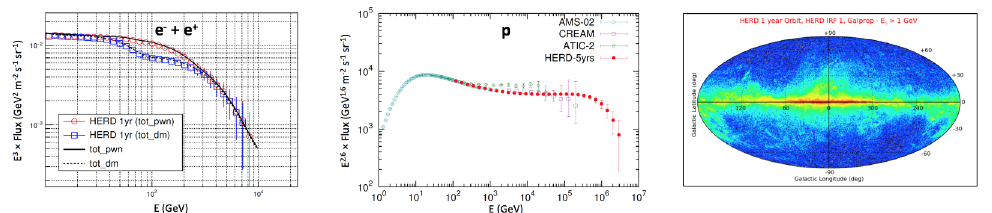
Figure 1. Expected e − + e + flux as measured by HERD with one year data accumulation. HERD will clearly distinguish between a smooth spectrum, due to a PWN, or a spectrum with a “kink”, due to DM (left). Expected proton flux as measured by HERD with five years data accumulation. HERD can reach the PeV region with unprecedented statistics (center). Expected HERD’s one-year map of the gamma-ray sky (right).